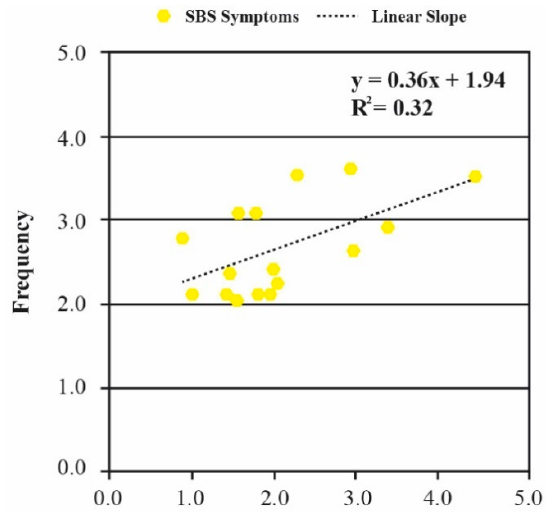
Figure 10. The frequency of SBS symptoms according to the CO 2 concentration.